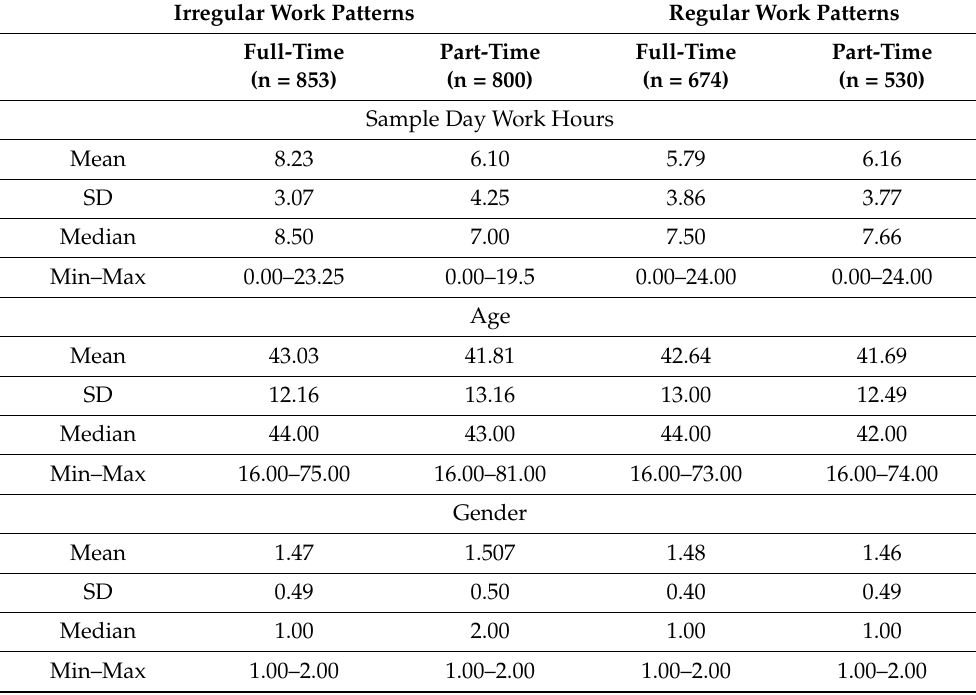
Table 3. Summary of the main explanatory